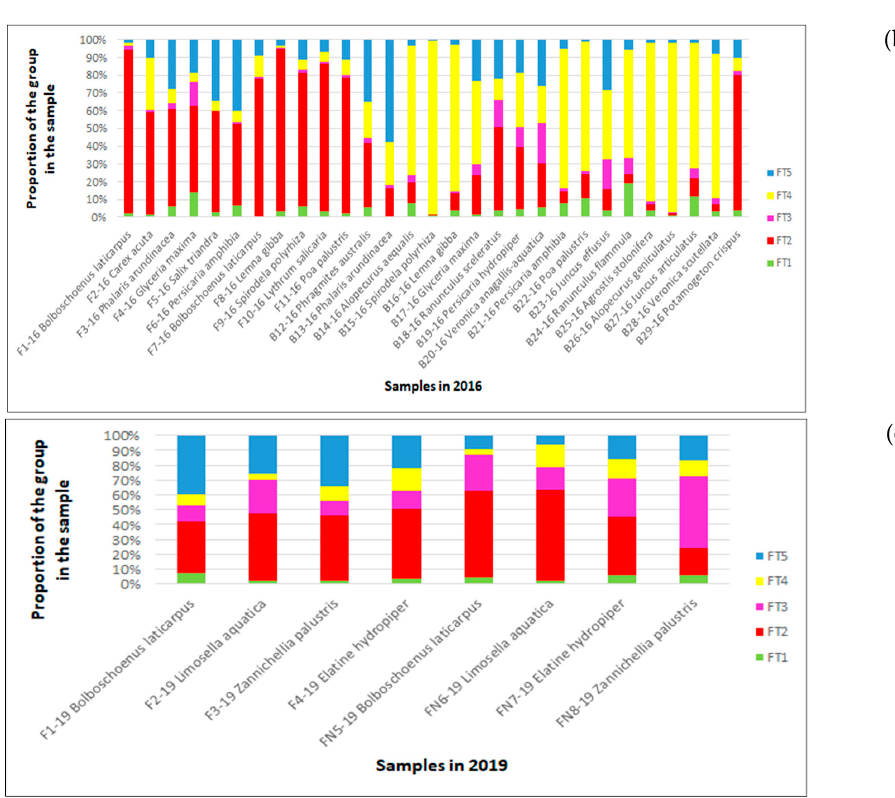
Figure 11. Relative representation of five diatom functional groups (FT1–FT5) in particular samples (based on quantities of diatom individuals within each of the groups). ( a ) Year 2015; ( b ) Year 2016; ( c ) Year 2019—only FD was sampled, but two different microsites were included.